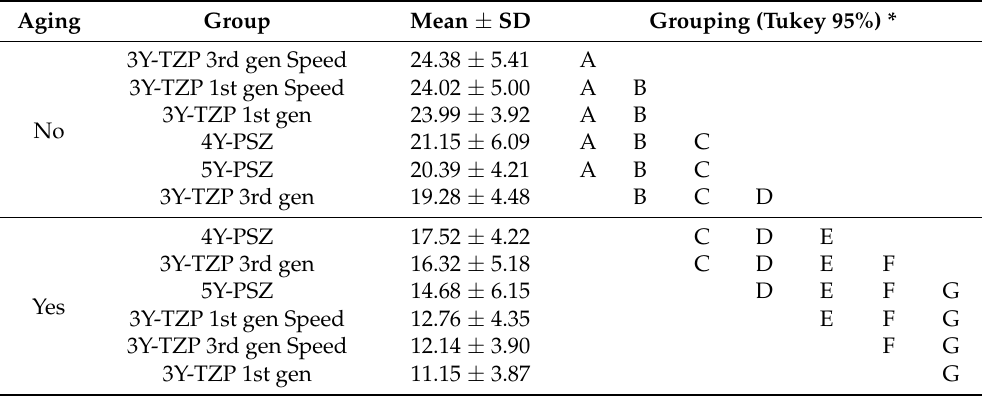
Table 3. Mean, standard deviation, and Tukey’s test (95%) of bond strength values according to the groups. Aging Group Mean ± SD